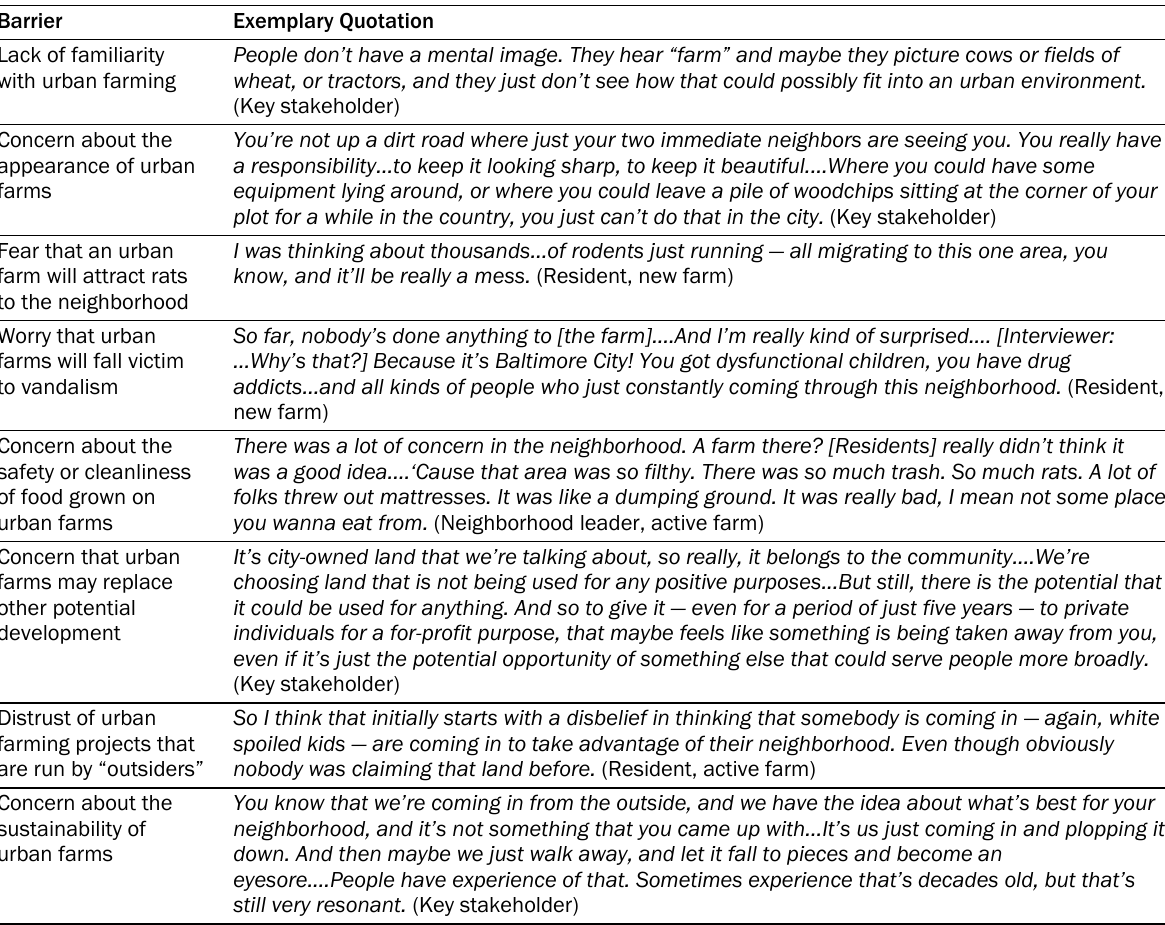
Table 1. Barriers to Gaining Community Buy-in for Urban Farming Identified in Qualitative Interviews